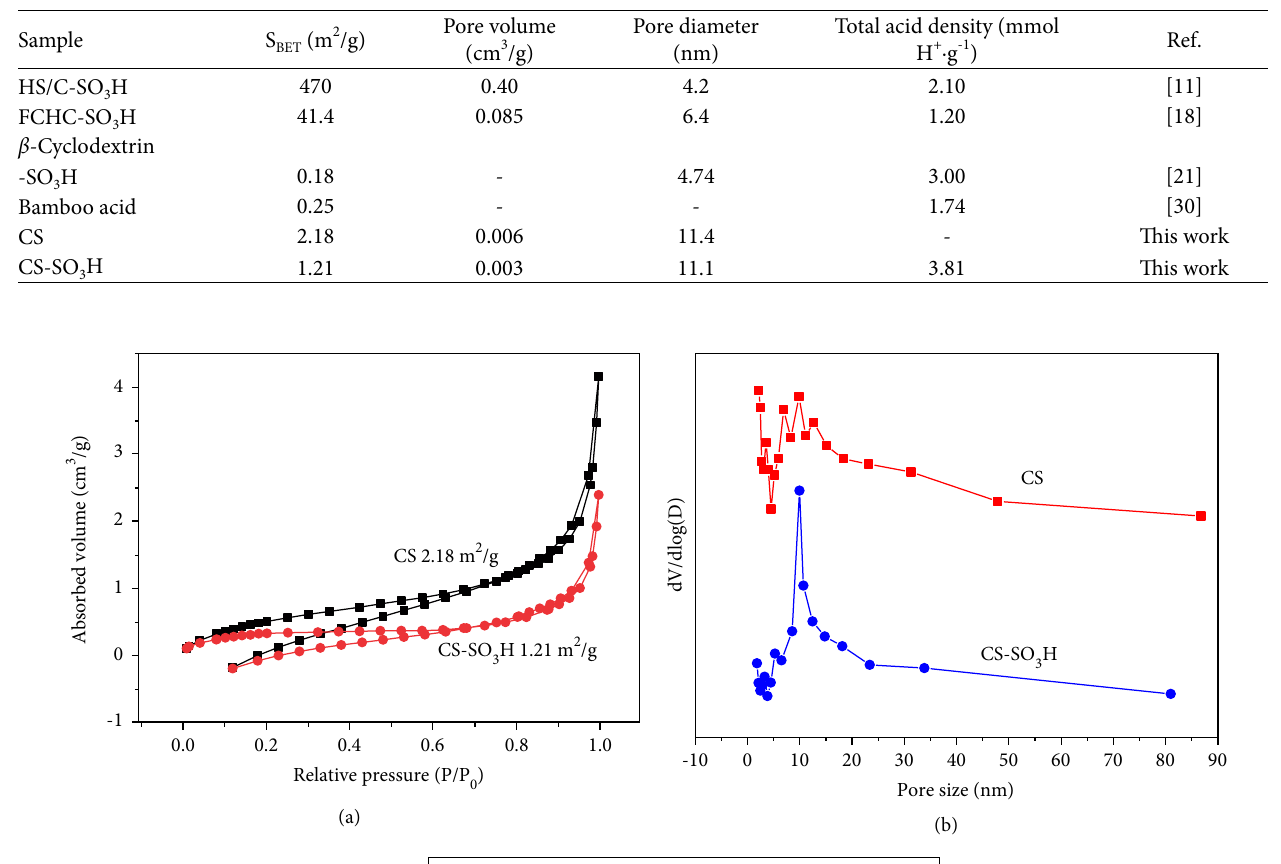
H, (b) BJH pore-size distributions of CS and CS-SO 3